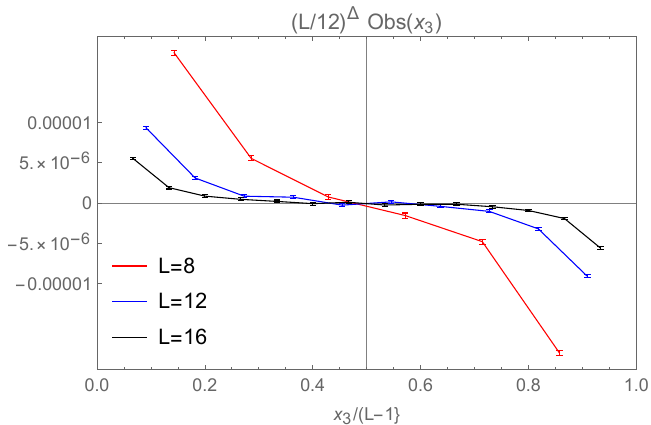
Figure 2 . In this plot (cid:1) = 2, testing (and ruling out) the virial current existence hypothesis.